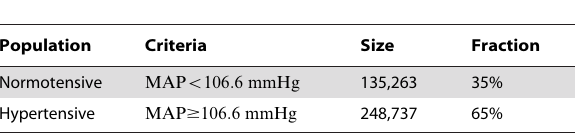
Table 4. Categorization of the virtual individuals into normotensive and hypertensive populations, based on mean arterial pressure